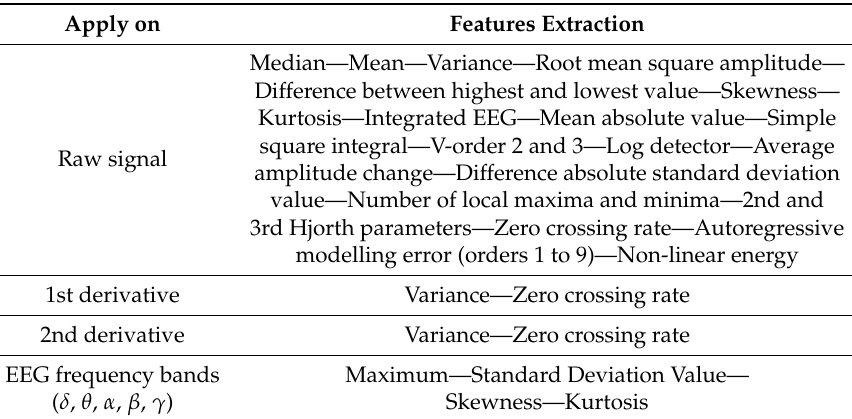
Table A1. Features extracted from the time